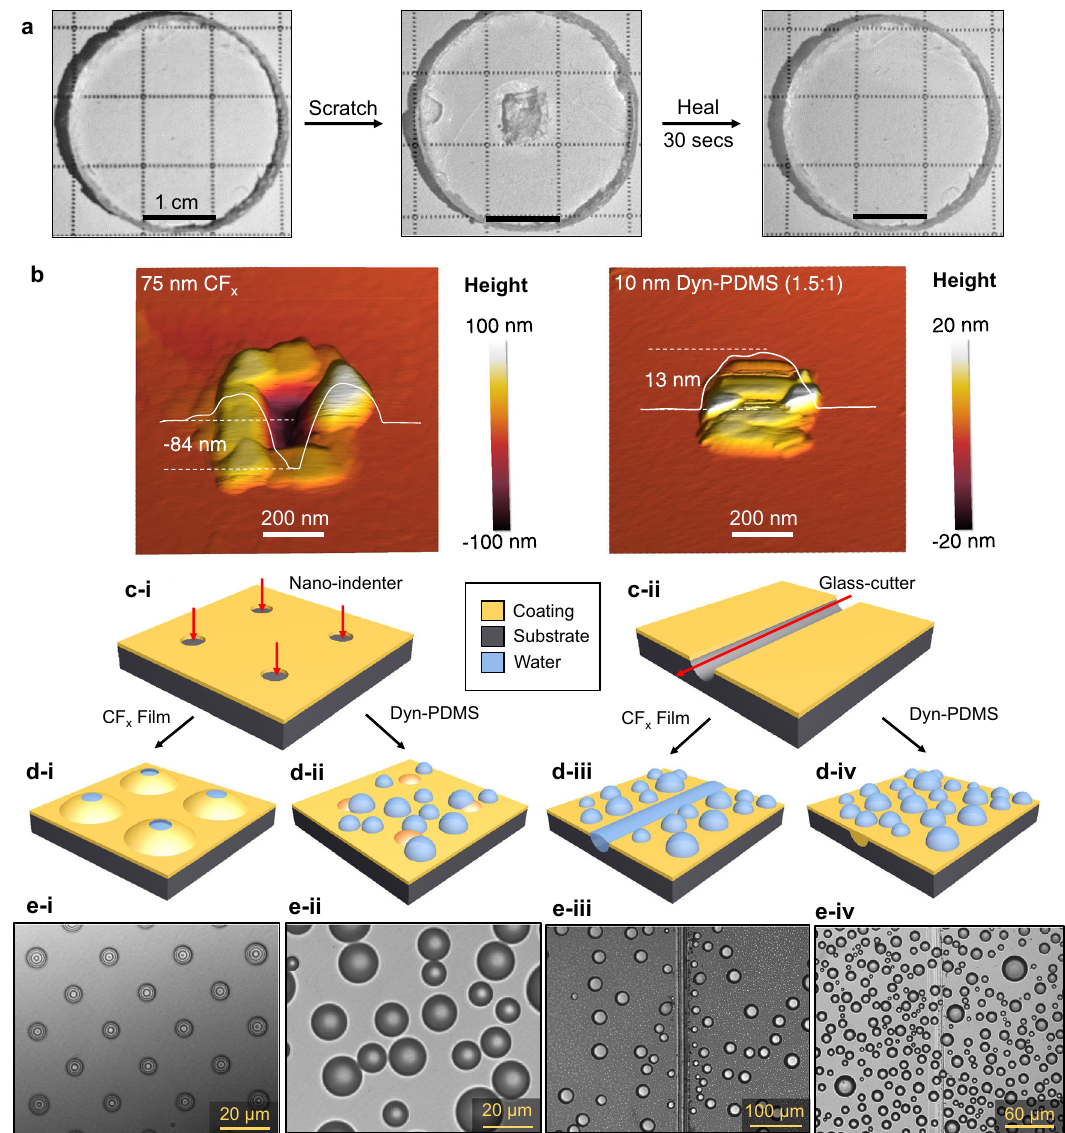
Fig. 2 Self-healing of dyn-PDMS fi lms. a Optical top-view images of a bulk dyn-PDMS cylinder healing at room temperature after being scratched in the center using a razor and healed at room temperature after 1 psi of pressure was applied. b Response of the materials to AFM area scratches with a contact force of 2 μ N. The area scratch was performed at the center 200 nm × 200 nm area, and left permanent damage on CF x (left image), while the self-healing dyn-PDMS fi lm (right image) was left with a bump of materials covering the damaged hole. Inset color bar: surface height from low (black) to high (white). c Comparison of dyn-PDMS and CF x thin- fi lm hydrophobicity. Schematic showing the observed response of the coating to ( c -i) arti fi cial nano-indented pinholes and ( c -ii) scratches. During steam condensation, optical microscopy images revealed that ( d -i and e -i) water blisters formed beneath pinholes on the CF x fi lm, while ( d -ii and e -ii) no blisters formed on the dyn-PDMS fi lm. Top-view optical microscopy images showed ( e -iii) droplets pinned near the linear water fi lm on the CF x coating after scratching, while ( e -iv) the scratch on the dyn-PDMS sample recovered and healed as evidenced by droplets nucleating directly on the scratch without signs of